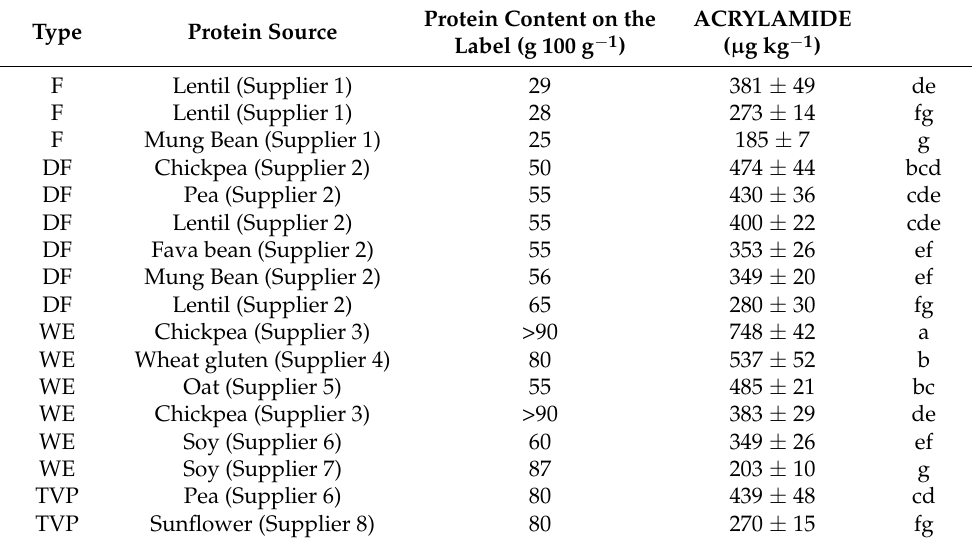
Table 1. List of the plant-based protein ingredients (PBPIs) with their relative acrylamide content and the results of the statistical